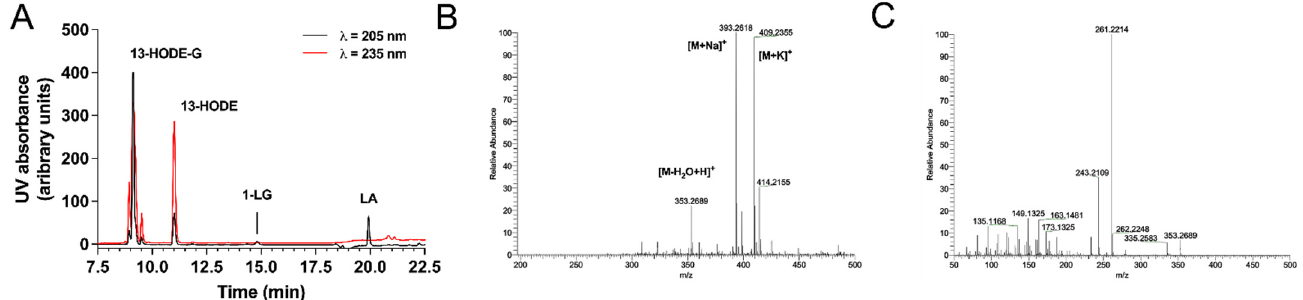
Figure 2. RP-HPLC chromatogram and mass spectrometry analysis of 13-HODE-G. ( A ) Separation of 13-HODE-G from other possible contaminants. The reaction products ( ∼ 350 µg) of 1-LG with soybean lipoxygenase were loaded onto the HPLC column and eluted as described in Material and Methods. ( B ) Positive electrospray ionization mass spectrometry (ESI+) of 13-HODE-G. Positive electrospray ionization mass spectrometry (ESI+) of 13-HODE-G yielded three main cations; [M-H 2 O+H] + was found at m / z 353.2689, [M+Na] + at m / z 393.2618 and [M+K] + at m / z 409.2355. ( C ) Collision-Induced Dissociation (CID) at Higher-energy collisional dissociation (HCD) of 20 eV of 13-HODE-G. CID of [M-H 2 O+H] + at m / z 353.2689 led to the dominant product ion of m / z 261.2214.